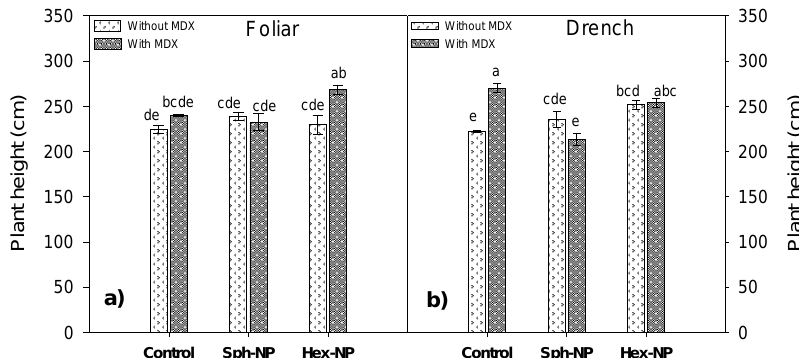
Figure 8. Effect of ZnO-NPs application on plant height. ( a ) Morphology*MDX*foliar application interaction, ( b ) Morphology*MDX*drench application interaction. Bars represent the standard error of the mean. Different letters indicate significant differences according to Tukey´s multiple comparison test ( p < 0.05). Sph = spherical, Hex = hexagonal.